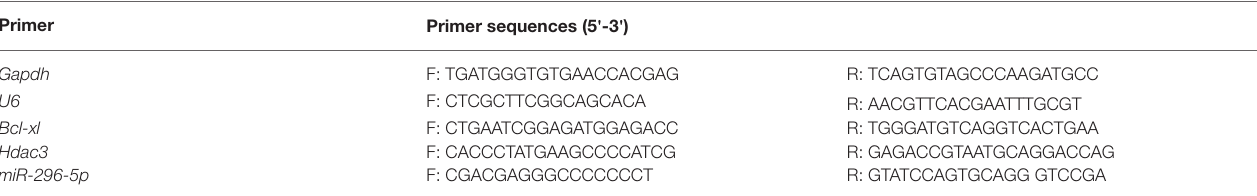
TABLE 1 | Primer sequences used in RT-qPCR analysis.